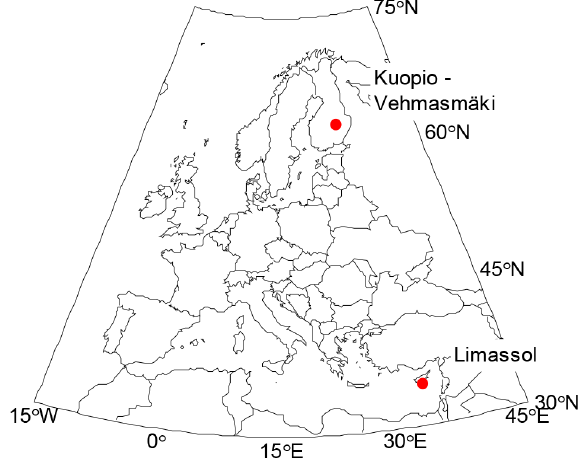
Figure 1. Locations of Vehmasmäki and Limassol measurement